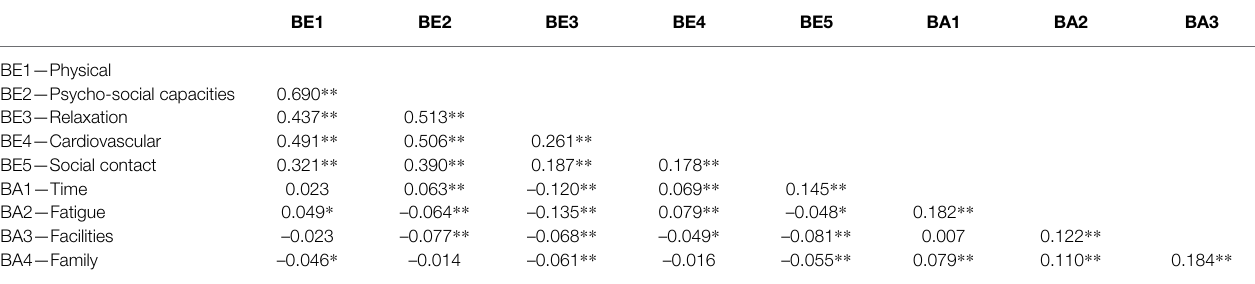
TABLE 4 | Correlation matrix between benefit and barrier factors. BE1 BE2